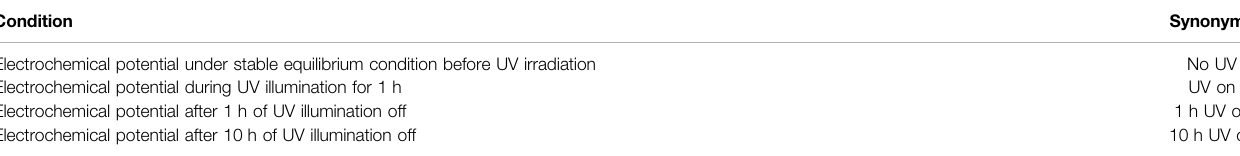
TABLE 4 | Conditions set for potentiodynamic polarization analyses.